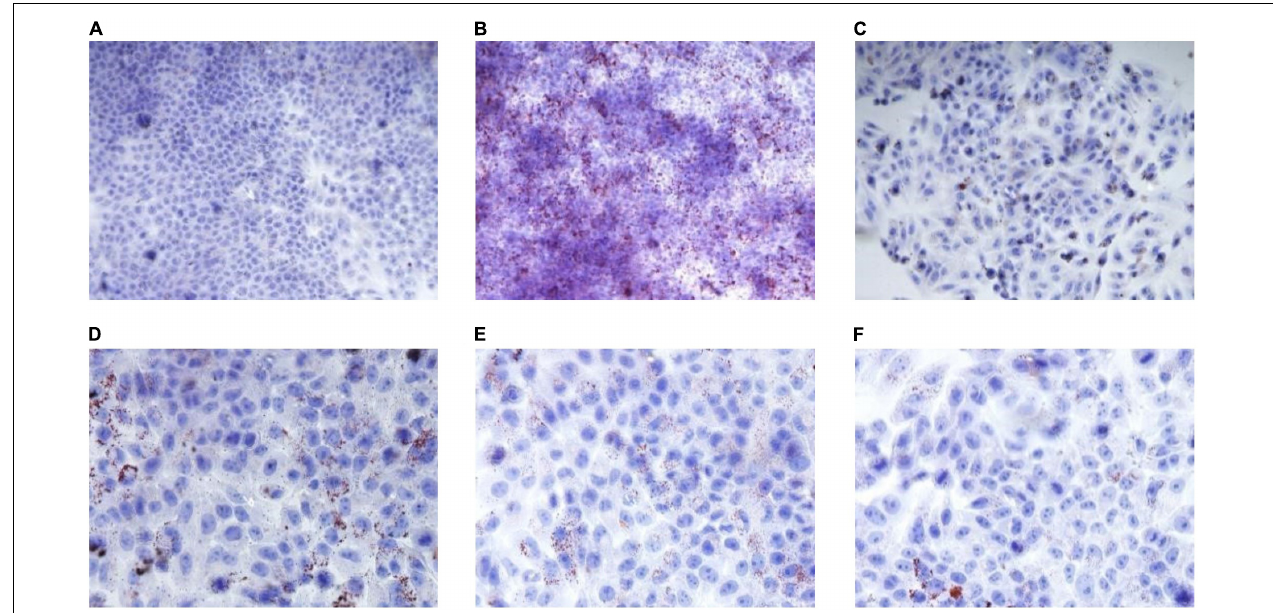
FIGURE 6 | Effect of RGW on lipid metabolism. (A) Blank; (B) negative; (C) positive; (D) RGW 25 µ g/ml; (E) RGW 50 µ g/ml; and (F) RGW 100 µ g/ml. TABLE 5 | The content of five short-chain fatty acids (SCFAs) in rat stools ( n = 8). Items CON DM MET RGW Acetic acid (umol/l) 347.76 ± 29.86 Propionic acid (umol/l) 62.33 ± 7.40 Butyric acid (umol/l) 58.44 ± 15.86 Valeric acid (umol/l) Isovaleric acid